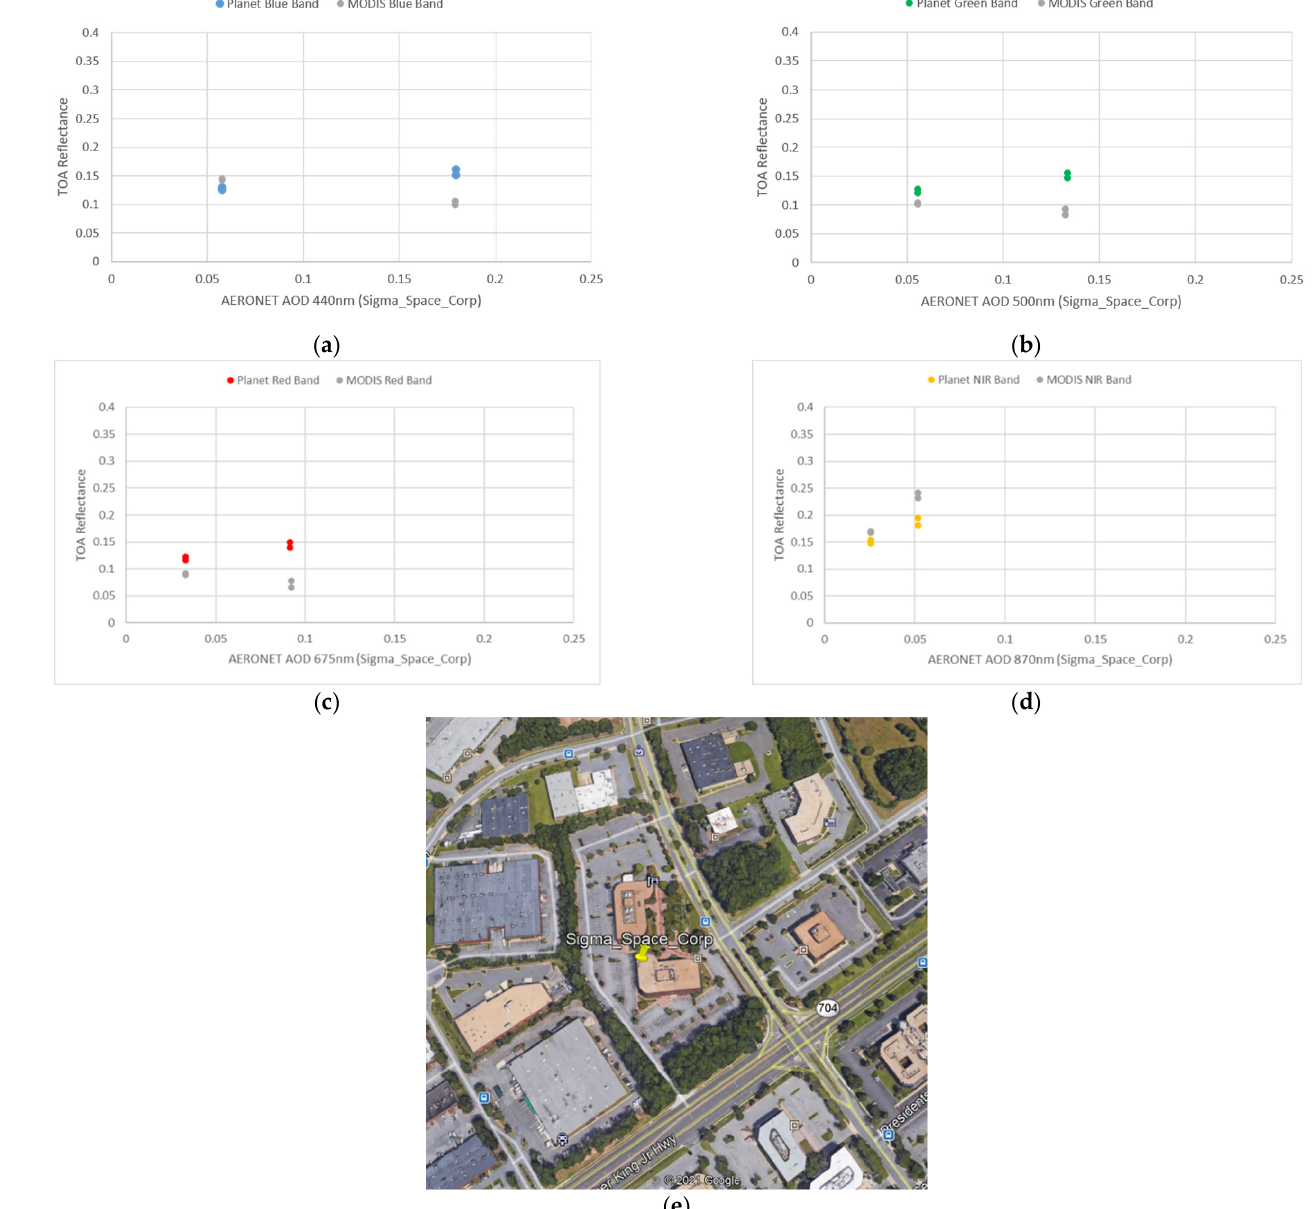
Figure A7. Data points from Figure 8 isolated for the Sigma_Space_Corp AERONET site. Data points from the 5 × 5 and 10 × 10 pixel average plots are combined. Lower AOD values are from 3/22/2017 and higher AOD values are from 7/14/2018. Plots are separated by ( a ) blue band; ( b ) green band; ( c ) red band; ( d ) NIR band. PlanetScope values are in color and MODIS values are in grey. The image in ( e ) shows a screenshot of the AERONET site location in Google Earth.